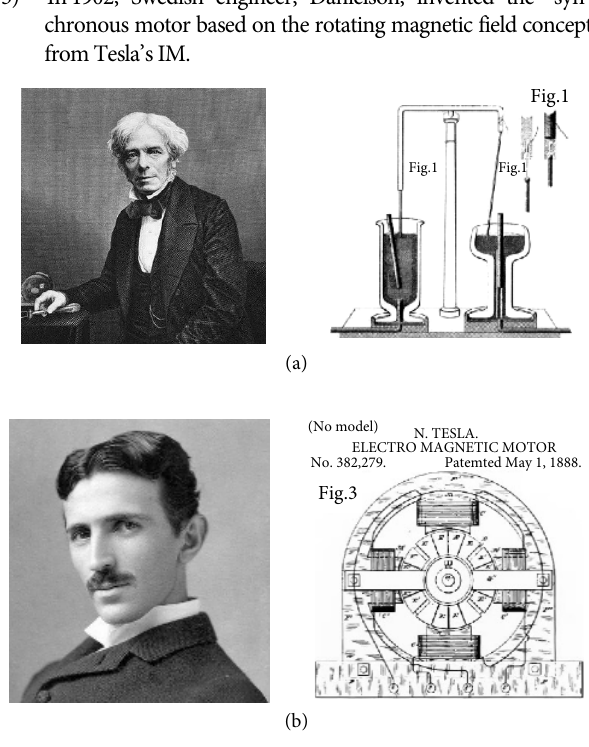
Fig. 1 Pioneers of electric motors and their achievements. ( a ) Michael Faraday and his electromagnetic experiment device. ( b ) Tesla and his IM pat-